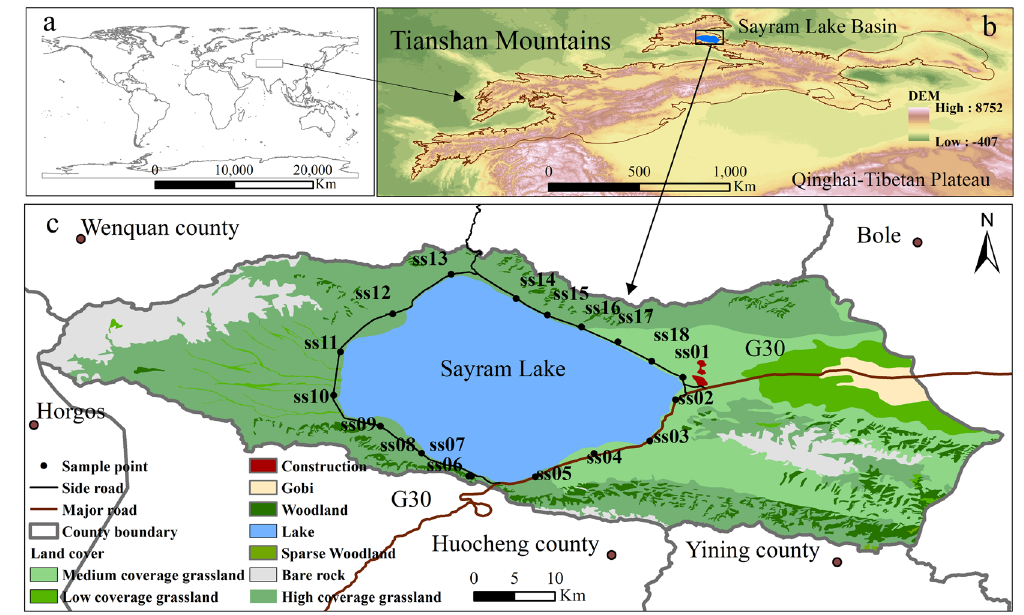
Figure 1. Location map and distribution of sampling points for the Sayram Lake Basin. The graphs ( a , b ) and ( c ) were generated by QGIS 3.26.3 (https:// www. qgis. org) with the global vector data from the GADM database (https:// gadm. org), the DEM data from the Natural Earth database (https:// www. natur alear thdata. com), and the land use data from the Resource and Environmental Science and Data Center database (https:// www. resdc. cn). The combination of graphs ( a , b ) and ( c ) was accomplished with linkscape 1.2.1 (https:// inksc ape.